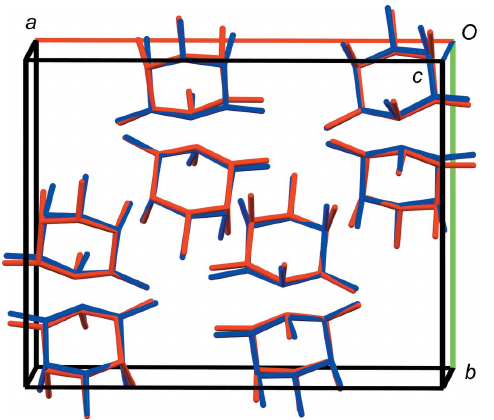
Figure 16 Temperature-dependent X-ray powder diffraction traces of allo -inositol ( 6 ) at 20, 170 and 200 (cid:2) C showing the phase transition of polymorph 6 -A (black and red), which is stable up to the minimum 170 (cid:2) C, to polymorph 6 -B at 200 (cid:2) C (blue).